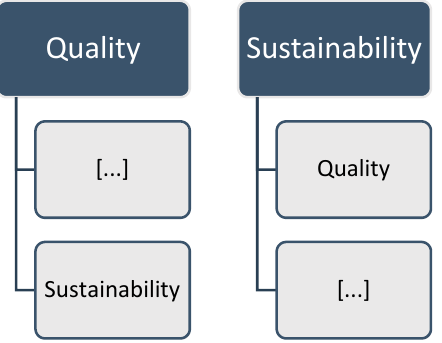
Figure 1. In conventional quality indexes, sustainability is (if mentioned at all) only one among other indicators (on the left ); Fischer [6], on the contrary, puts sustainability in the center (on the right )—without decreasing its importance, quality is defined as one among other sustainability-related values (own illustration).